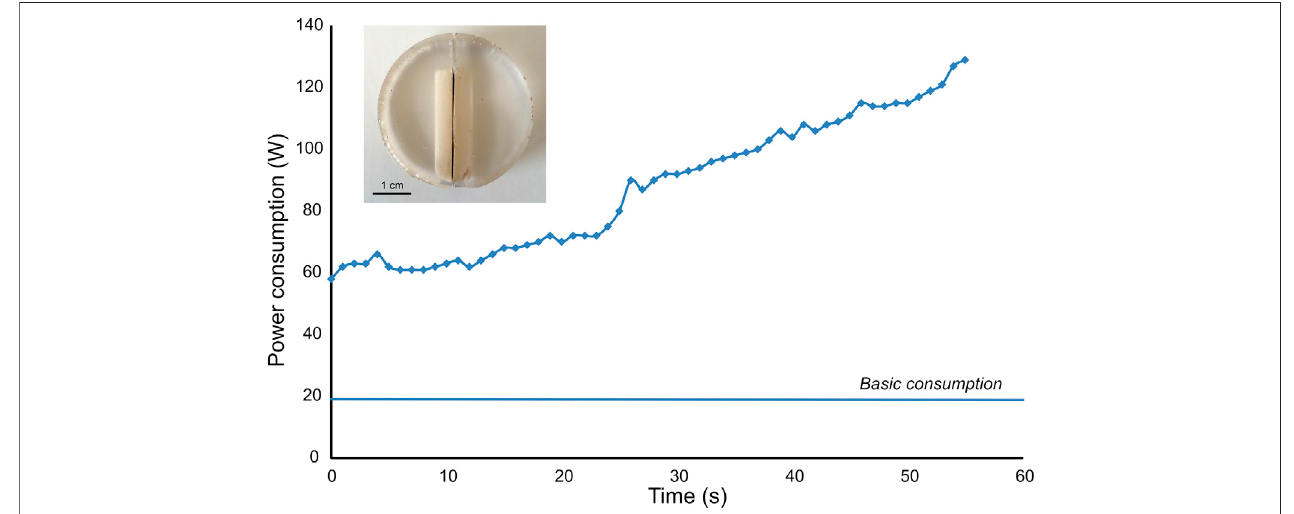
FIGURE 3 | Evolution of power consumption over time during the cutting of a chalk sample (in insert) using the Presi P100 disc saw.